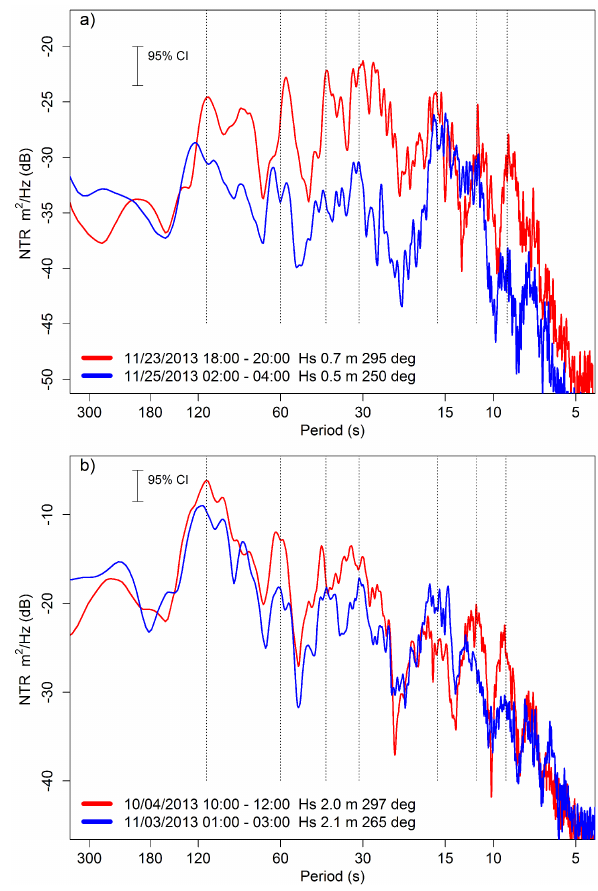
Figure 8. (a) Power spectral density estimates of 1Hz nontide residual water level over 2h periods with offshore significant wave heights of 0.5 and 0.7m and arrival directions of 250 and 295 ◦ . (b) Power spectral density estimates of 1Hz nontide residual wa- ter level over 2h periods with offshore significant wave heights of 2.0 and 2.1m and arrival directions of 265 and 297 ◦ . Dotted lines correspond to harbor modes (112, 60, 41, 31, 16 and